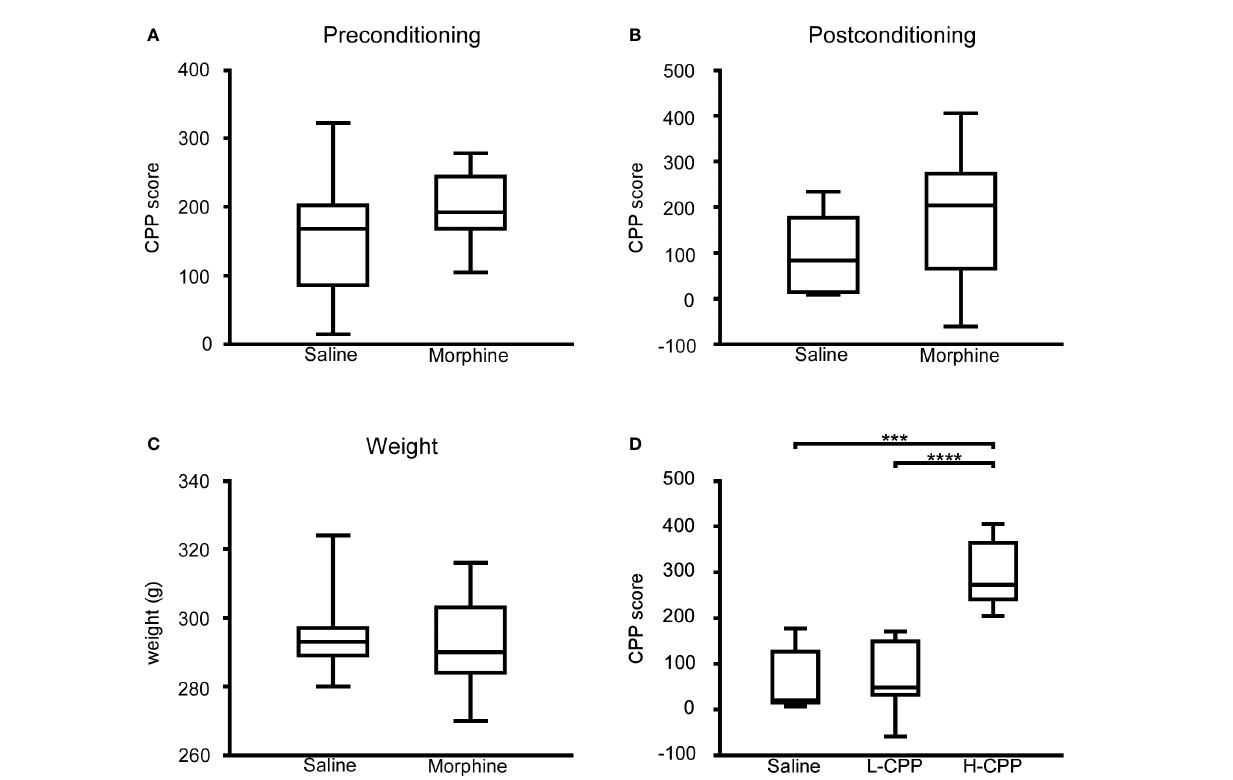
FIGURE 1 | (A) The conditional place preference (CPP) score of rats were compared between the morphine and saline group in the preconditioning phase, and there was slight difference appeared in the CPP score between the morphine group and saline group. (B) The CPP score of rats were compared between the morphine and saline group in the postconditioning phase, and there was slight difference appeared in the CPP score between the morphine group and saline group. (C) The weights of rats were compared between the morphine and saline group in the preconditioning phase. There was no signi fi cant difference between the weight of posttreatment for morphine and saline group. (D) The CPP score of rats were compared among the saline, L-CPP and H-CPP group in the postconditioning phase. The CPP score of H-CPP is signi fi cantly higher than L-CPP and saline group, and there was no difference between the CPP score of L-CPP and saline group. The CPP score means the difference between time spent in the drug-paired side after CPP training and time at baselinSe.t udent ’ s t test was used to analyze the data. The central line shown in each box plot indicates the median of data. Whiskers extend to cover the whole range of values. Statistical signi fi cance was accepted at p<0.05. *p<0.05; **p<0.01; ***p<0.001;